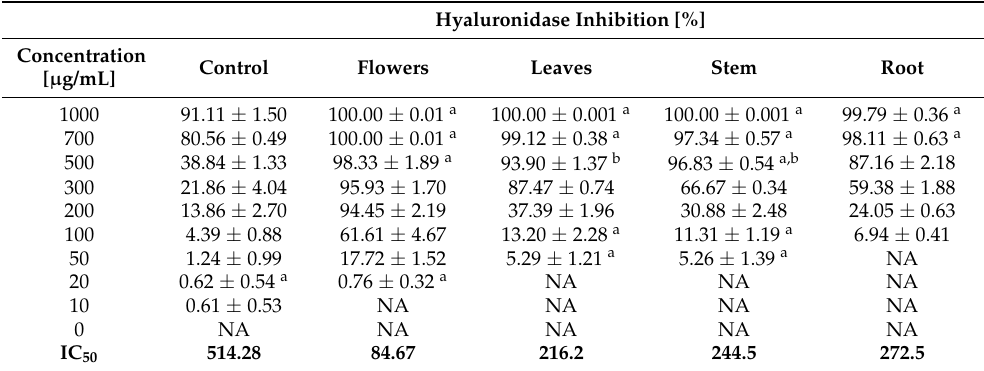
Table 4. Antihyaluronidase activity of extracts of different morphological parts of Atriplex sagittata Borkh. Hyaluronidase Inhibition [%] Concentration [ µ g/mL]